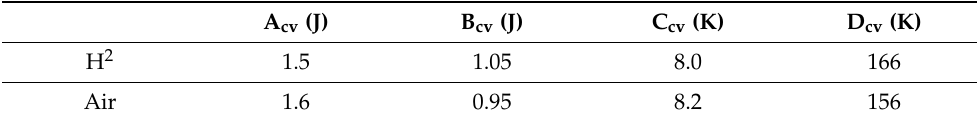
Figure 9. Charpy energy–temperature curves for tests performed on mini Charpy specimens made in X65 steel with and without hydrogen embrittlement. Table 2. Values of constants of Equation